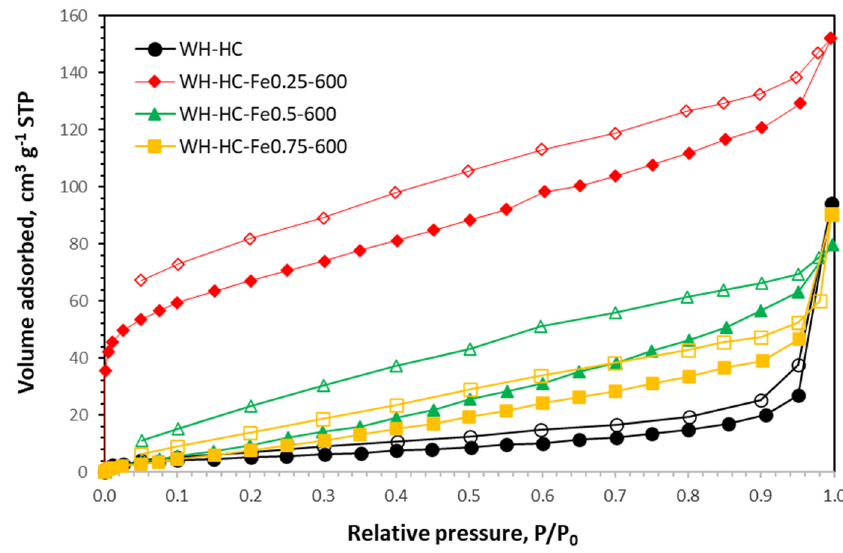
− 196 ◦ C of WH-HC and HCs prepared by Fe-assisted Figure 5 . N 2 adsorption isotherms at − 196 °C of WH-HC and HCs prepared by Fe-assisted HTC . Figure 5. N 2 adsorption isotherms at